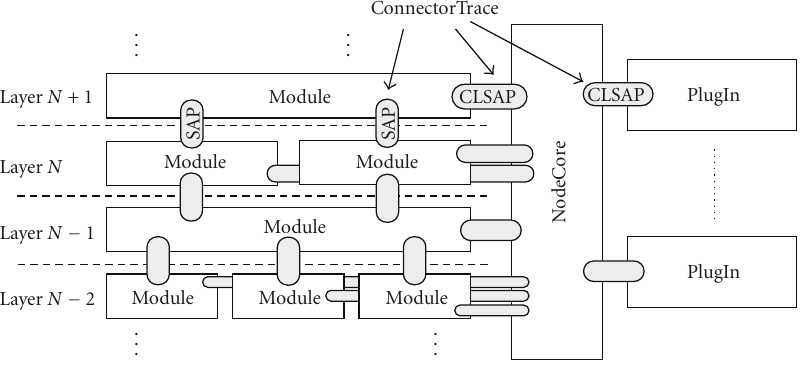
Figure 1: Example of a general multilayer architecture within the Miracle